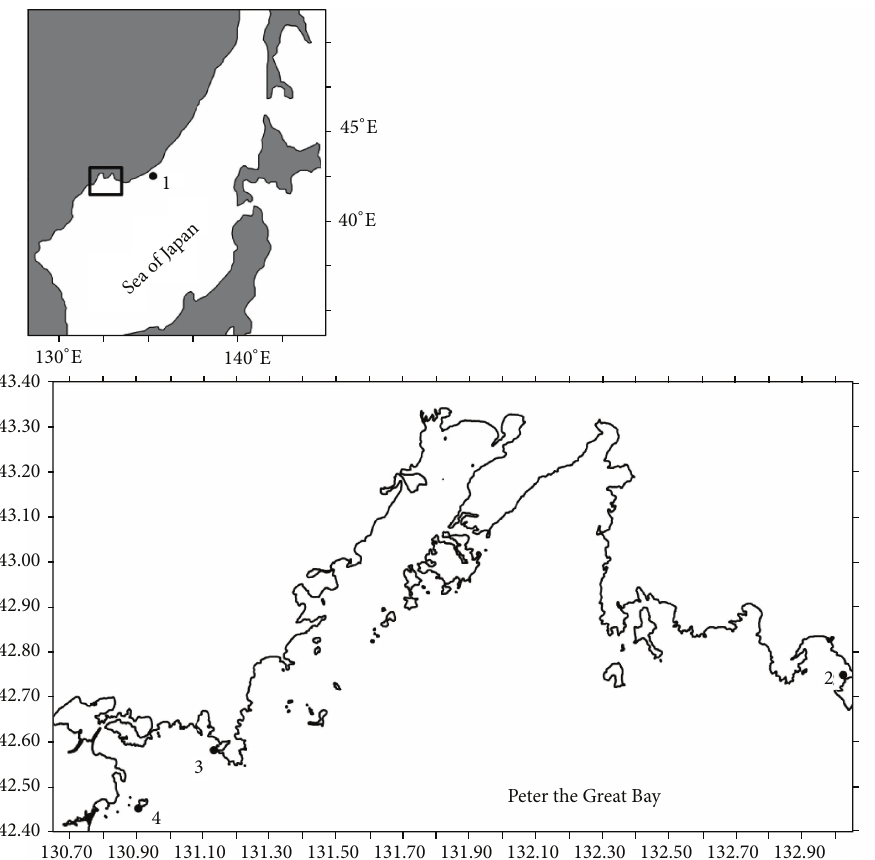
Figure 1: Sampling sites of scallop Patinopecten yessoensis : (1) Melkovodnaya Bay; (2) Ozero Vtoroe Bay; (3) Vityaz Bay; (4) Zapadnaya Bay of Furugalm Island. On both maps, black circles indicate the sites of scallop